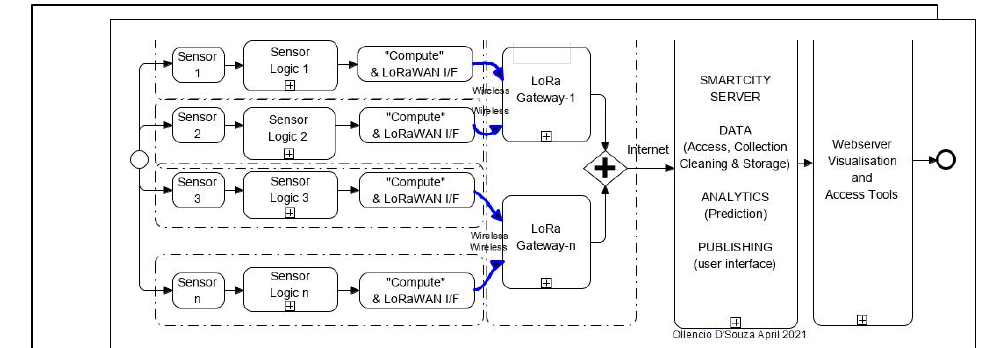
Figure 30. Spreadsheet to perform multiple trials to test for consistency using the confusion matrix.